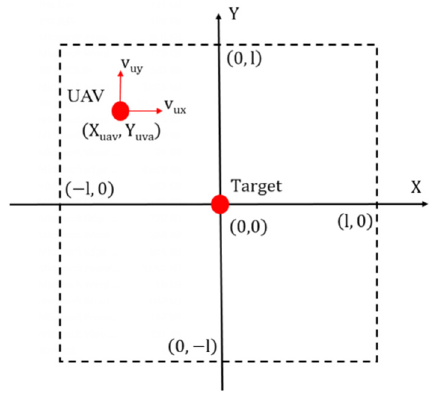
Figure 4. Training model for UAV target tracking problem.